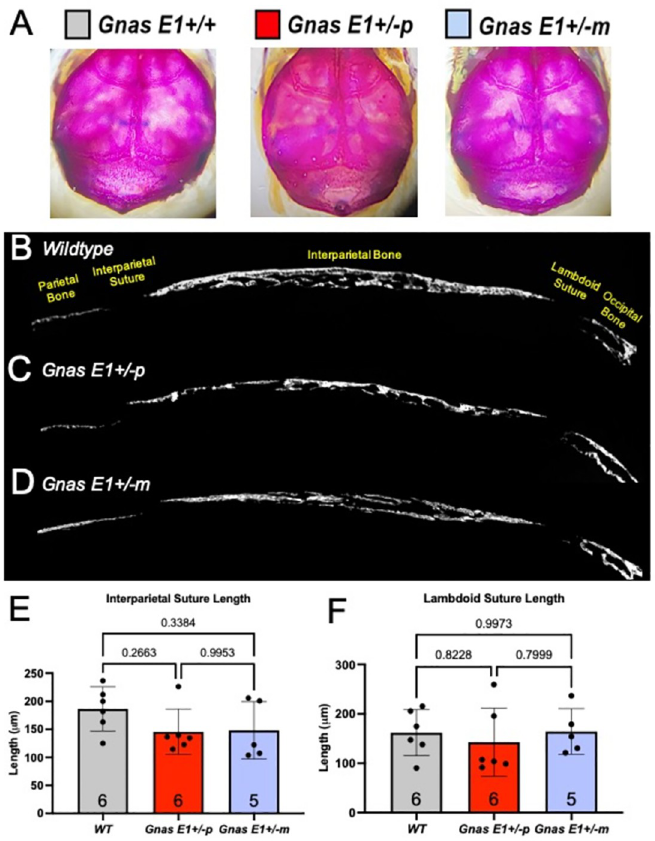
Fig 4. Gnas E1+/- mice do not display significant variations in the rate of interparietal or lambdoid suture closure. (A) Representative whole mount images of the cranium of 2-week-old WT, Gnas E1+/-p and Gnas E1+/-m mice. (B-D) Representative images of the cranium of 1-week- old (B) WT, (C) Gnas E1+/-p and (D) Gnas E1+/-m mice stained with calcein blue to visualize total mineral content and distance of interparietal and lambdoid sutures. (E-F) Quantification of the (E) Interparietal and (F) Lambdoid suture length demonstrated no significant differences between 1 week-old WT and Gnas E1+/- mice. Sample size per genotype per experiment is listed on each graph. All statistical tests were performed using a two-way ANOVA with post-hoc Tukey test for multiple comparisons, and p - values are displayed for each comparison. and Gnas E1+/- mice (Fig 5). Whole mount staining of P14 mice identified that both Gnas E1 +/-m and Gnas E1+/-p mice appeared to have a potential narrowing of the spheno-occipital synchondrosis (SOS) when compared to WT (Fig 5A–5F). For orientation, the sphenoid bone (SB) and occipital bone (OB) are also identified within Fig 5. Histologic analysis of the SOS of P7 (Fig 5G–5I) and P14 (Fig 5J–5L) mice revealed that at P7, Gnas E1+/-m and Gnas E1+/-p mice exhibit a significant reduction in SOS length when compared to WT (Fig 5M). This observation was of particular interest because the SOS is a structure recognized to be essential for craniofacial development, and accelerated closure of this structure in humans and mice have been correlated with the development of midface hypoplasia [52]. Therefore, we per- formed histomorphometric analysis of the SOS in P7 and P14 WT and Gnas E1+/- mice by utilizing a combination of both EdU pulse-chasing to label proliferative chondrocytes and Alkaline Phosphatase (ALP) histochemistry to label hypertrophic chondrocytes (Fig 6A–6F). We did not observe any significant differences in SOS length, numbers of EdU+ chondrocytes, resting and proliferative zone length, or hypertrophic zone length between P14 Gnas E1+/-